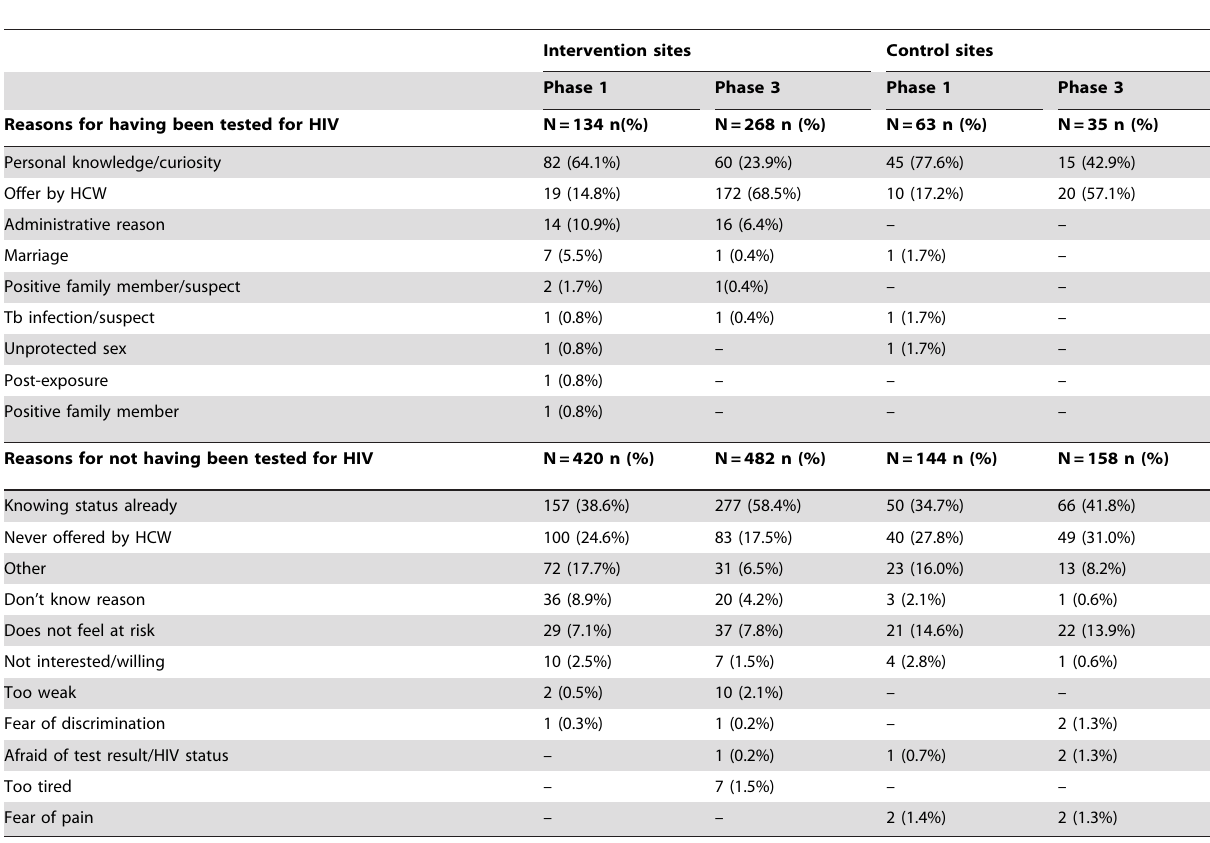
Table 5. Reasons for having been tested or not having been tested for HIV among health facility attendees by study phase, PITC study, Rwanda,